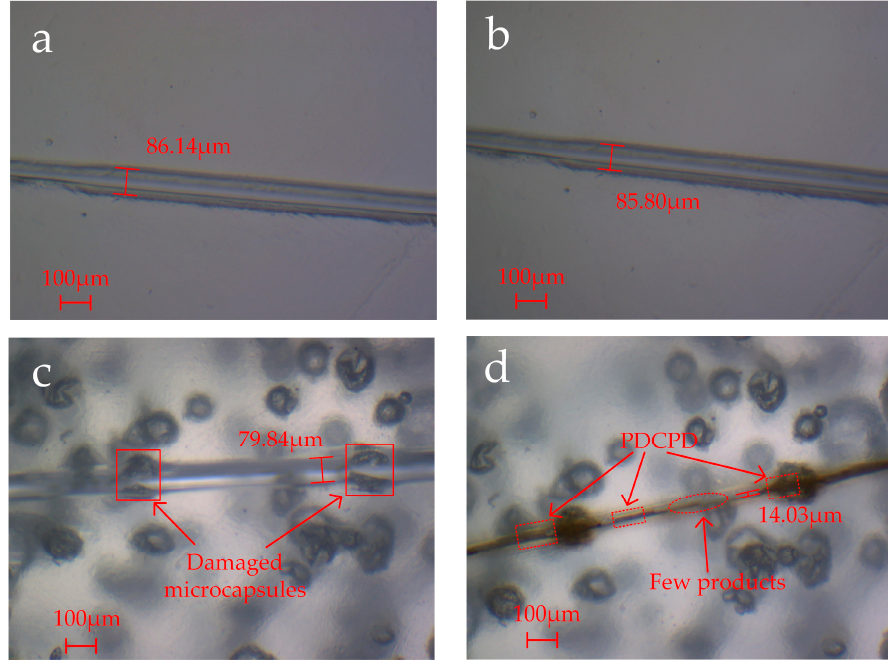
Figure 3. Morphology of the scratch. ( a ) Unheated pure LDPE. ( b ) Heated pure LDPE. ( c ) Unheated composite. ( d ) Heated composite.